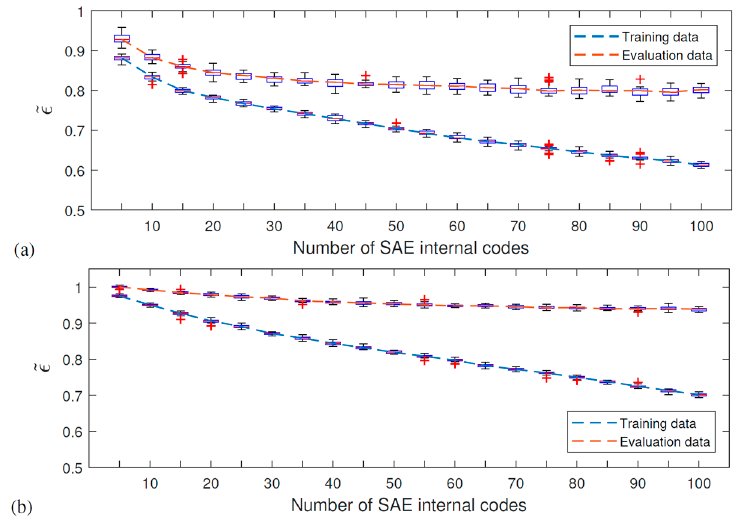
Figure 11. SAE internal codes × SAE reconstruction error for the Várzea Nova viaduct. ( a ) Accelerometer 1. ( b ) Accelerometer 2. Table 6. Várzea Nova viaduct: correct classification rates in percentage.